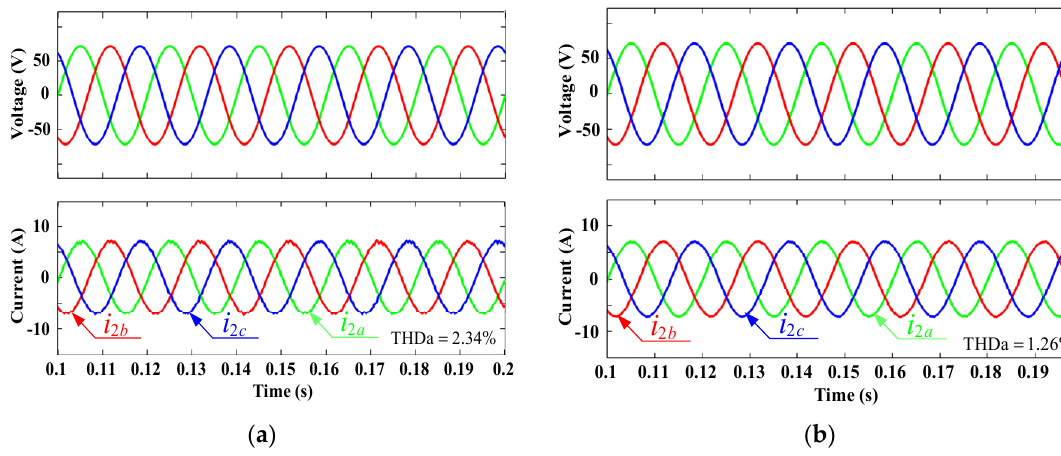
Figure 6. The simulated performance comparison results between ( a ) the proposed control method and ( b ) the FCS-MPC with full status measurements.